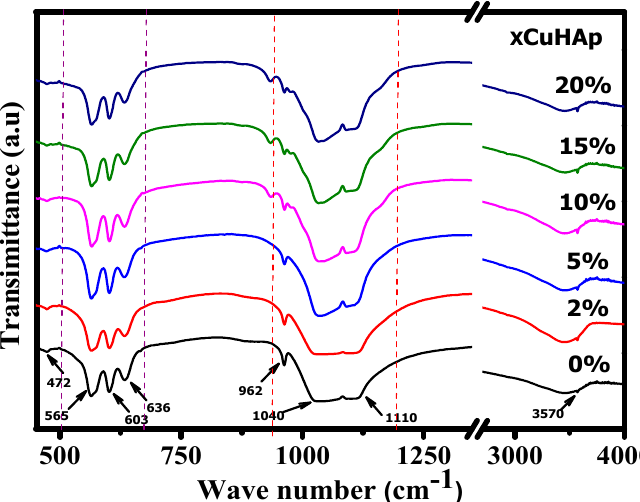
Figure 2. FTIR spectra of CuHAp catalysts with different Cu loadings.